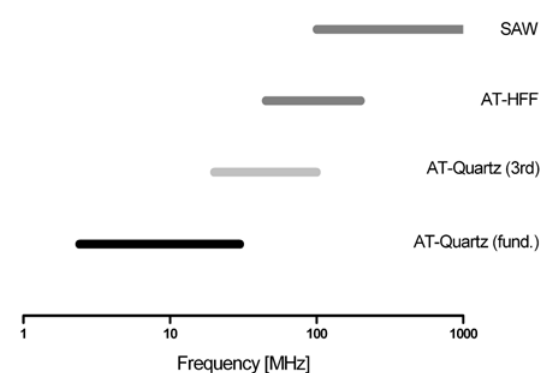
Figure 1. Typical frequency ranges of different types of gravimetric sensors based on oscillating quartzes